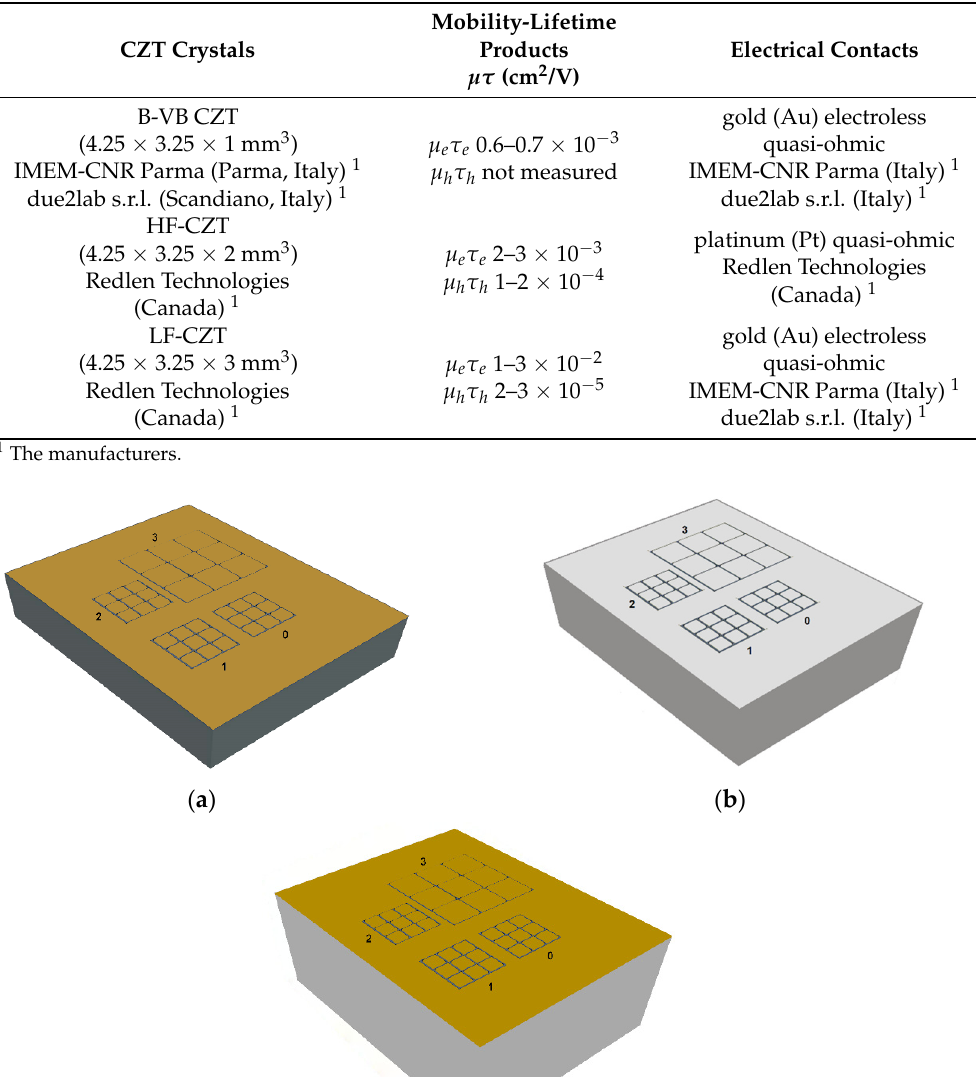
Table 1. The key characteristics of the CZT pixel detectors.